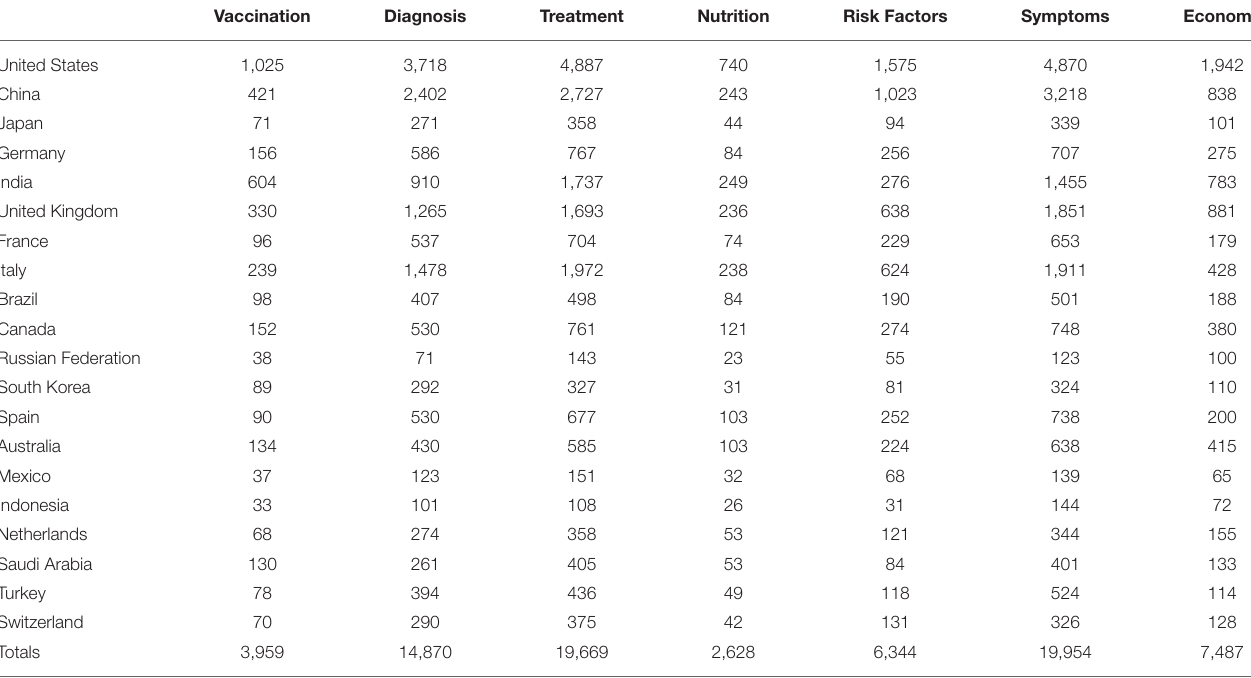
TABLE 1 | Total number of early publications on selected research domains related to COVID-19 from the 20 highest-ranked countries according to GDP. Vaccination Diagnosis Treatment Nutrition Risk Factors Symptoms